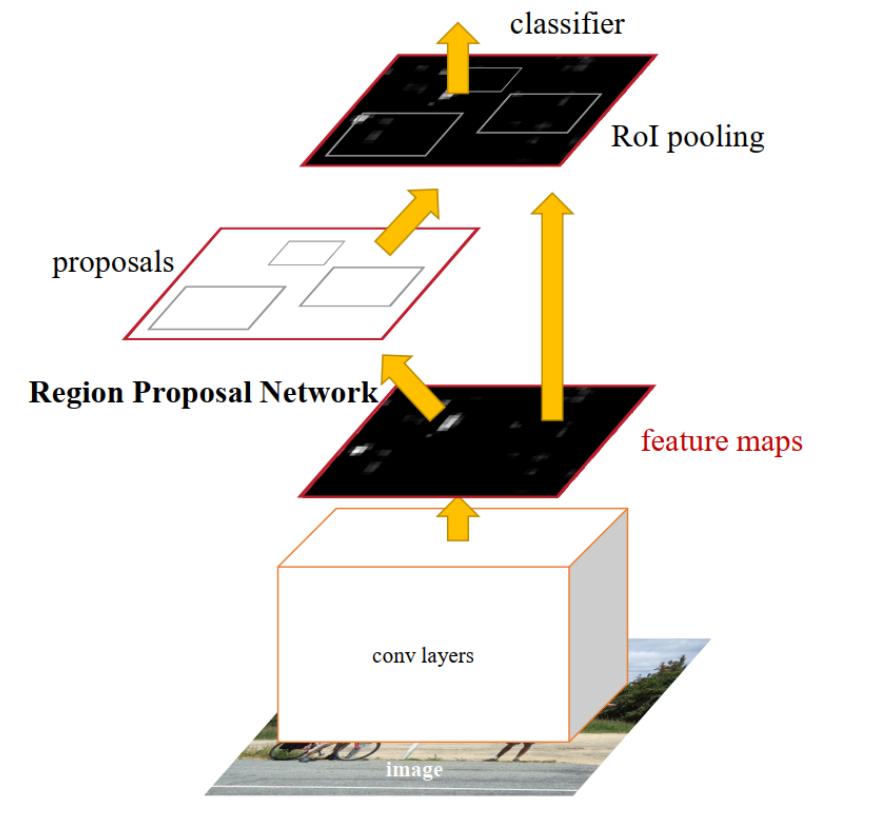
Figure 12. The explained architecture of Faster R-CNN [23]. The base network generates the feature maps from input images and propagates them to RPN and ROI pooling. The RPN generates region proposals which are refined by ROI pooling to perform regression and classification. Reprinted from